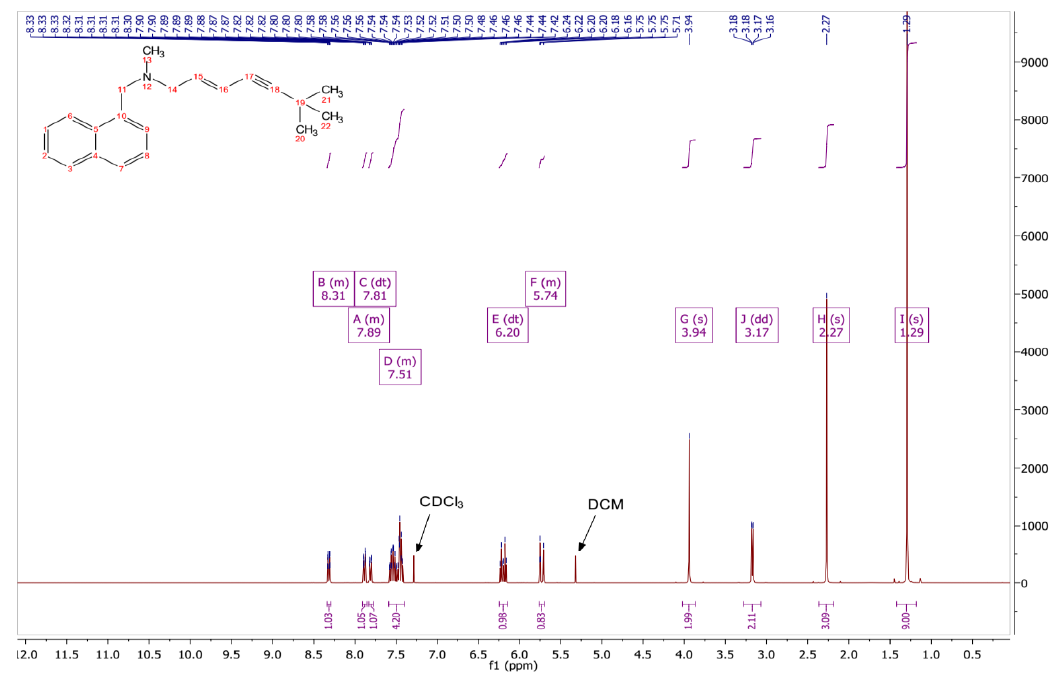
Figure 1. 1 H NMR spectrum of TBF-free base.